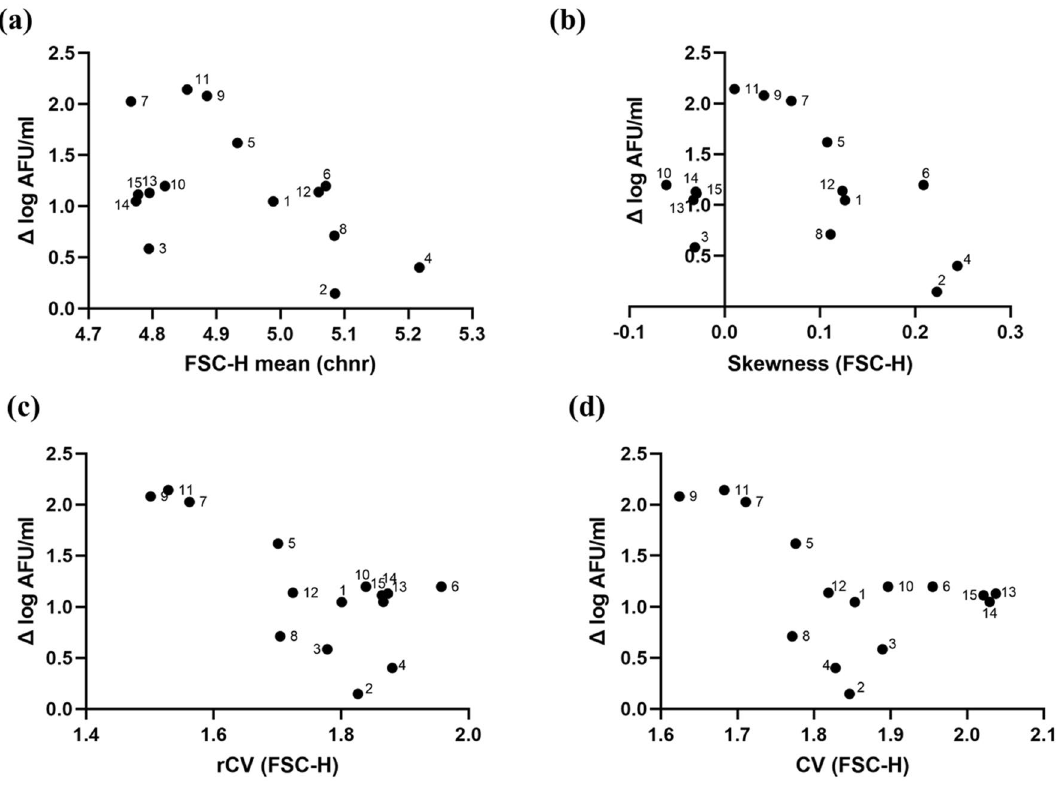
Figure 2. Morphology descriptors calculated for 15 conditions ( a ) FSC-H mean, ( b ) Skewness of FSC-H, ( c ) rCV of FSC-H, ( d ) CV of FSC-H vs growth (Δ log AFU/ml). Chnr-channel mean FSC-H described above. rCV displayed high correlation with r value = − 0.7137, p-value = 0.0028, whereas CV and skewness displayed low correlation (r value = − 0.4968 and − 0.3601 respectively) with p-value > 0.05 (Supplementary Material, Table S4-3). In contrast to FSC-H, the pulse width distributions appeared as distinct subpopulations that were classified with five separate gates (Fig. 4a). Pulse width correlates to the time it takes for a cell to pass the laser interrogation point and provides information of its size 30,38,39 . Previous reports have stated that there is a tendency for cells to align along their long-axis by the hydrodynamic focusing of the cytometer 40–42 . With support of this previous work, the separation into distinct subpopulations may indicate chains with a varying number of uniform cells with distinct lengths. From the SEM analysis the presence of both single cells and chains with a different number of cells, and more of the latter at 30 °C compared to 37 °C was observed (Fig. 3). The frequency of cells within each of the five gates (Fig. 4a) was calculated for the total population, as well as for intact and damaged cell subpopulations. The frequency of total cells in gate 2 correlated well with the bacterial growth (Δ log AFU/ml) (Fig. 4b), (r = 0.8083 and p-value = 0.0003). The cultivations with strong growth (condi- tions 7, 9 and 11) had above 60% of the cells in gate 2 suggesting that the population is less heterogeneous which is similar to other heterogeneity variables determined in the study (CV, rCV and skewness). Intact and damaged cells displayed a significant difference in subpopulation distribution. A paired t -test highlighted the significance between damaged and intact cell populations in gate 1 and 2 with p - values < 0.0001. The damaged cell subpopulations predominantly ended up in gate 1 for all the cultivations (> 40%), while the living cell had the majority in gate 2 (> 40%) for all cultivations except for conditions 2, 4 and 6 (Supplementary Material, Table S4-4). The frequency of intact cells in gate 2 was found to depend on culture condition (Fig. 4c). Surface plots of frequency of cells in gate 3–5 were made to visualise which conditions resulted in larger cells (Supplementary Material, Fig. S4-6). High oxygen levels, high initial pH, and low temperature resulted in larger bacteria, possibly by acting as triggers for chain formation, which was inversely correlated to cell growth. From the correlation coefficient analysis, oxygen concentration had a high positive correlation r = 0.7406 and significant impact on pulse width distribution (frequency of cells in gates 3–5) (p - value = 0.0016). Temperature and initial pH had negligible to low correlation with a r-value of − 0.2355 and 0.3766 respectively with p-value > 0.05. Batch variation was based on the triplicates of the central point and displayed low variability for CV and rCV (< 1%) and skewness (5.5%). As for pulse width distribution gate 1–3 consisted > 80% of the total cells (except for con- dition 2 and 4) displayed low variability (< 5%) and gate 4 and 5 which consisted ≤ 20% of total cells displayed much higher variability (> 5%).